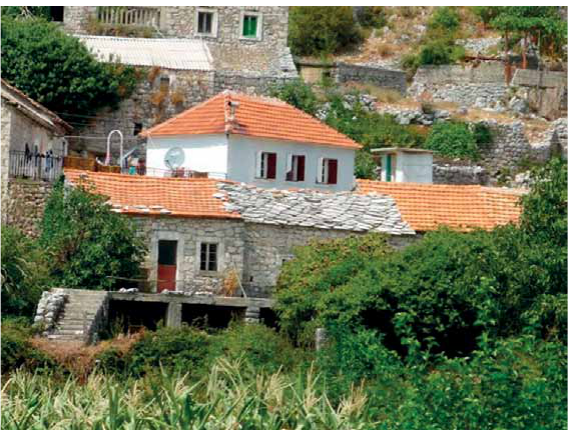
fig. 3. Traditional Mountain Village House fig. 4. Traditional Coastal